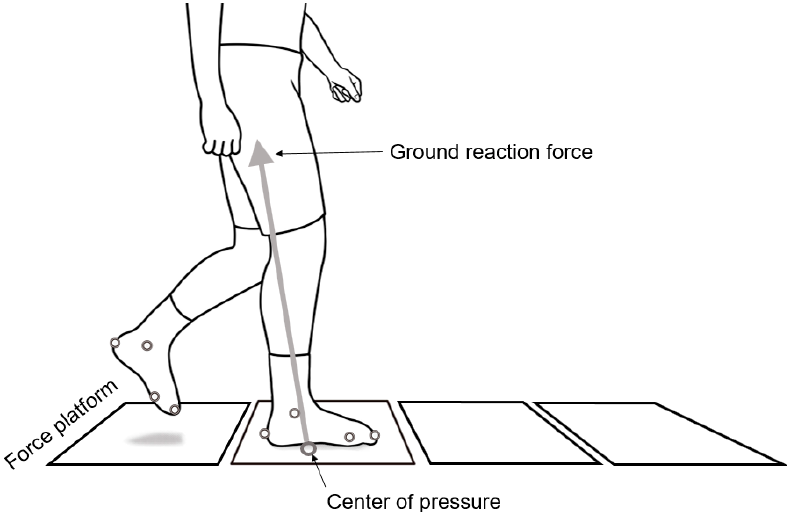
Figure 1. Experimental setup (at UAMS) showing four force platforms which were used to assess center of pressure (COP) movement during single-support phase (only one limb is in contact with the ground) of walking.